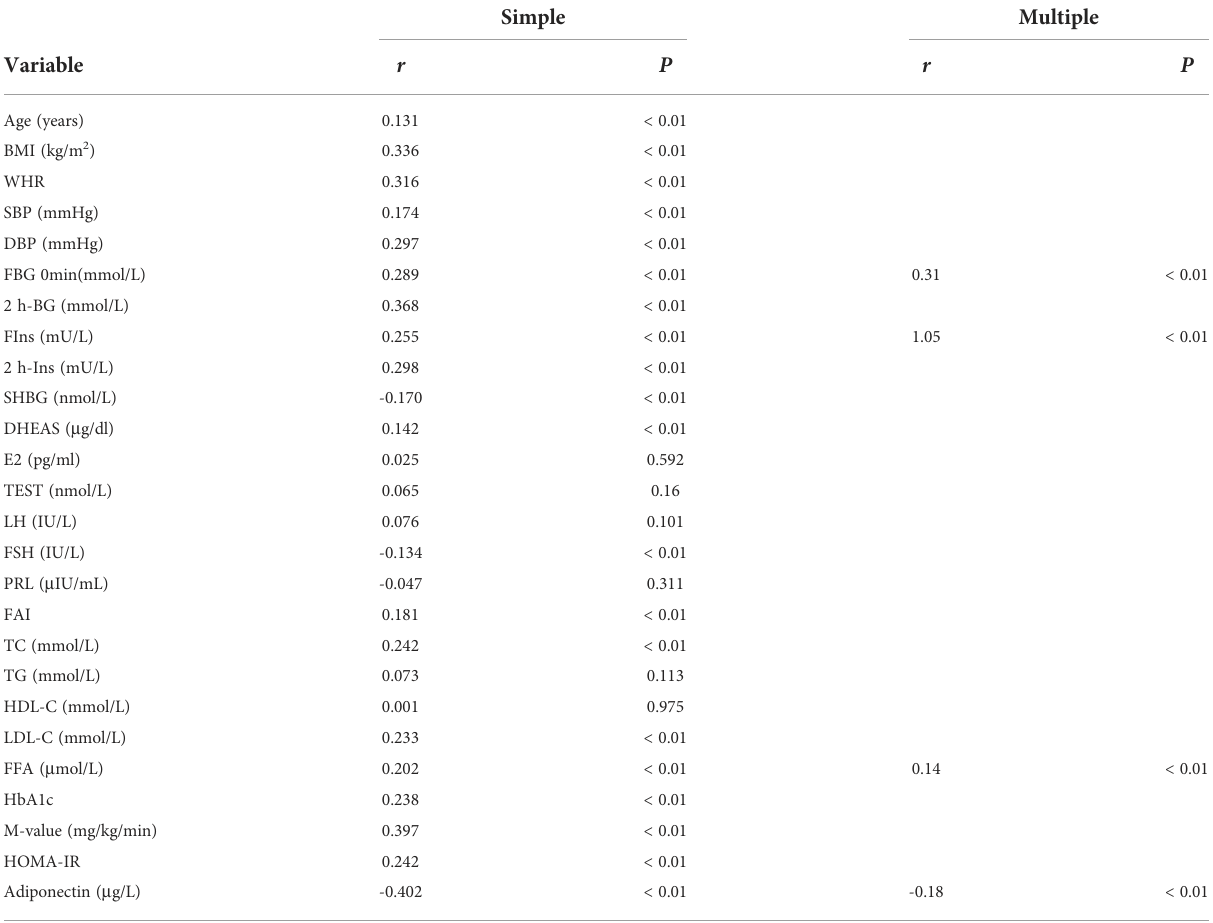
TABLE 3 Correlation analysis of variables associated with circulating GPHB5 levels in the population. Simple Multiple Variable r P